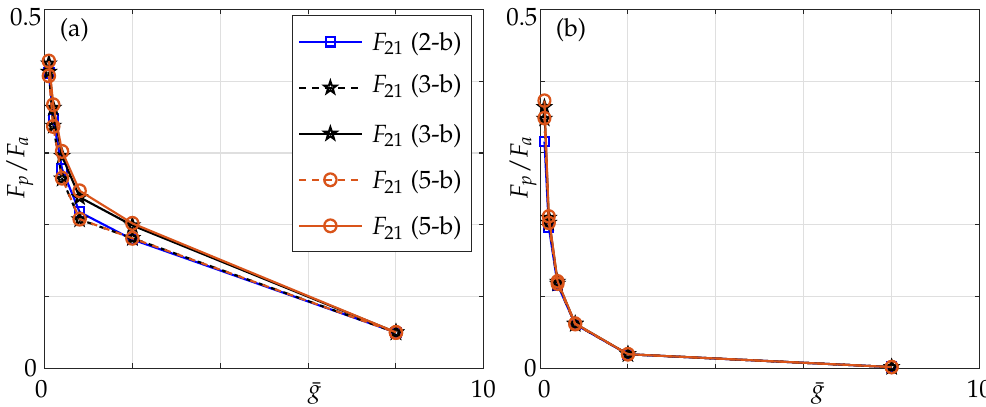
Figure 16. Coupling ratio of the passive to the active beam for different configurations for ( a ) Re = 0.1; ( b ) Re = 100; nearest neighbours: dashed line; all members: solid lines; with 1–0: blue, 1–0–0: black and 1–0–0–0–0: orange denoting the respective configurations under